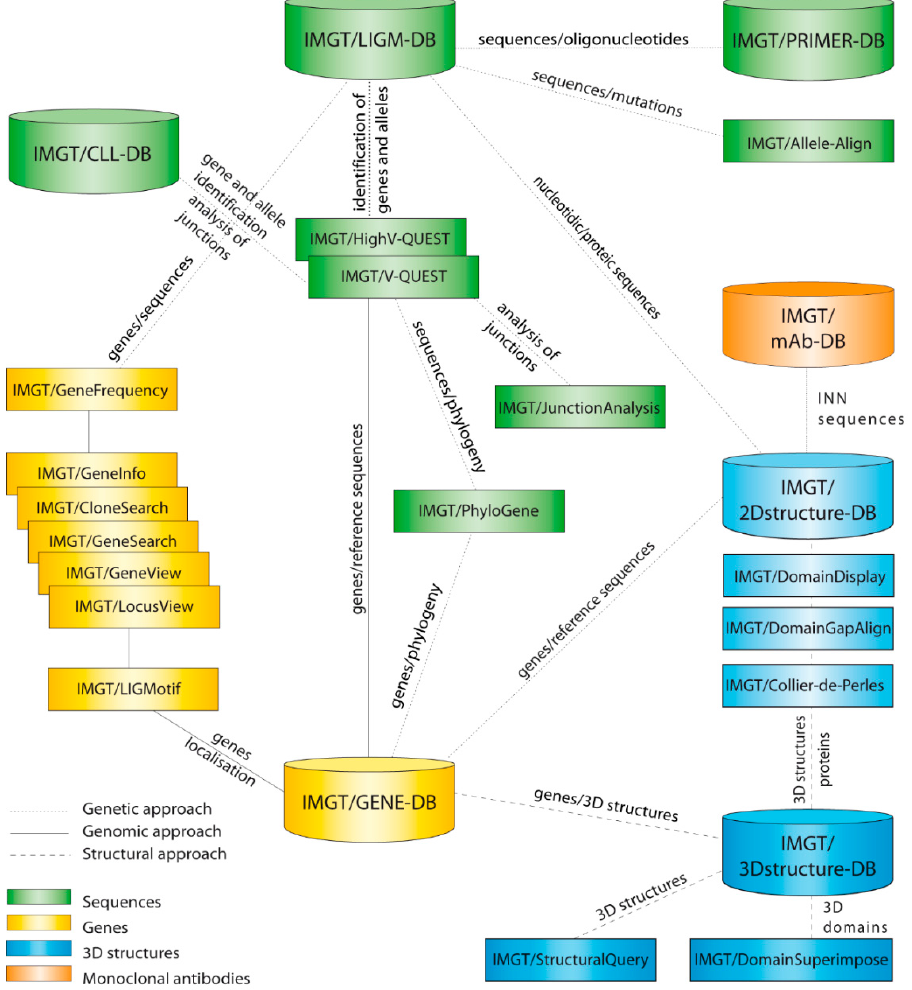
Figure 1. IMGT ® is the international ImMunoGenetics information system ® (https://www.imgt.org) [11–21]. The IMGT web resources (>25,000 pages, the IMGT Marie-Paule page) are not shown. IMGT/mAb-DB, the interface for therapeutic monoclonal antibodies and fusion proteins for immune applications (FPIA), has been available online since 4 December 2009 and IMGT/HighV-QUEST portal for the next generation sequencing (NGS) high-throughput sequence analysis since 22 November 2010 (with permission from M-P.Lefranc and G. Lefranc, LIGM, Founders of IMGT ® from the international ImMunoGeneTics information system ®